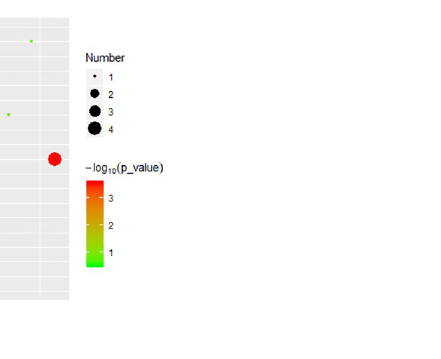
Fig 4. Significant metabolic pathways for 44